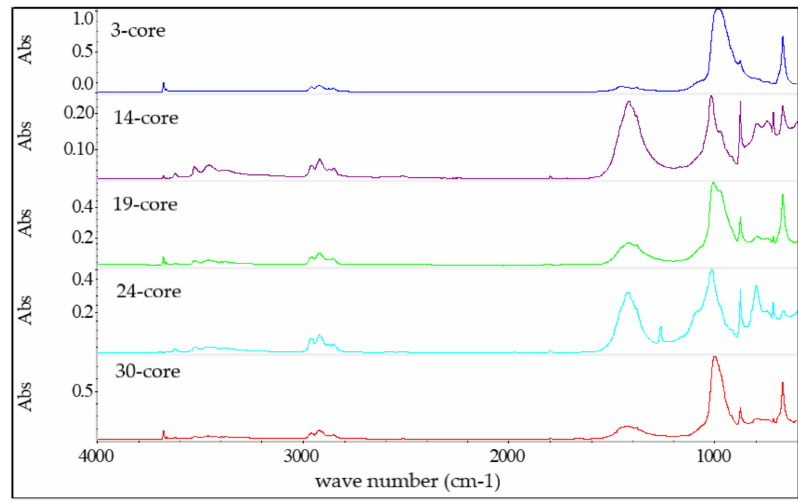
Figure 7. FTIR spectra of the bedding of tested cables.